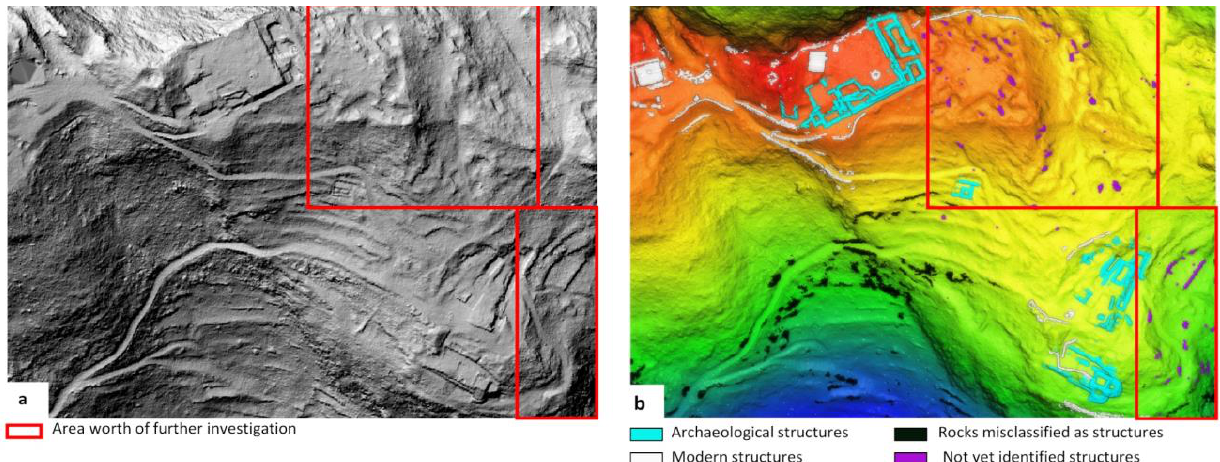
Figure 6. VTs to facilitate the study of the DTM for Dataset_1: (a) shaded DTM; (b) height map with previously segmented structures, now divided into categories of interest.